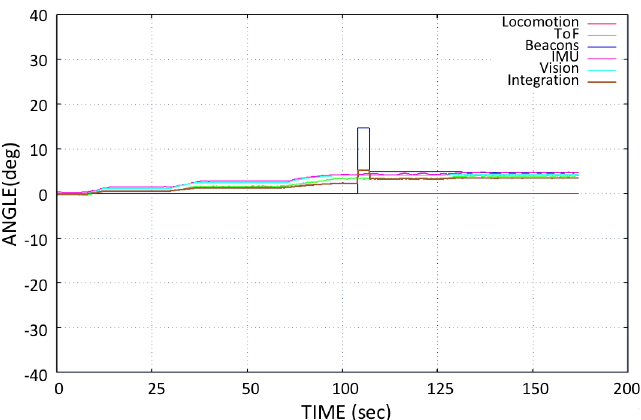
Figure 19. Flat movement test: Moving the Mantis v2 along the window parallel to the frame in the base, in an open